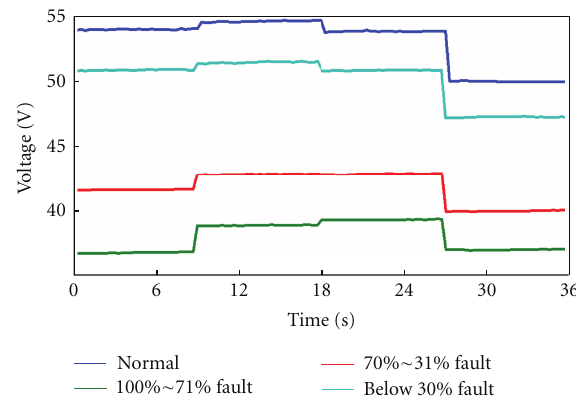
Figure 15: Each fault voltage curve in the first